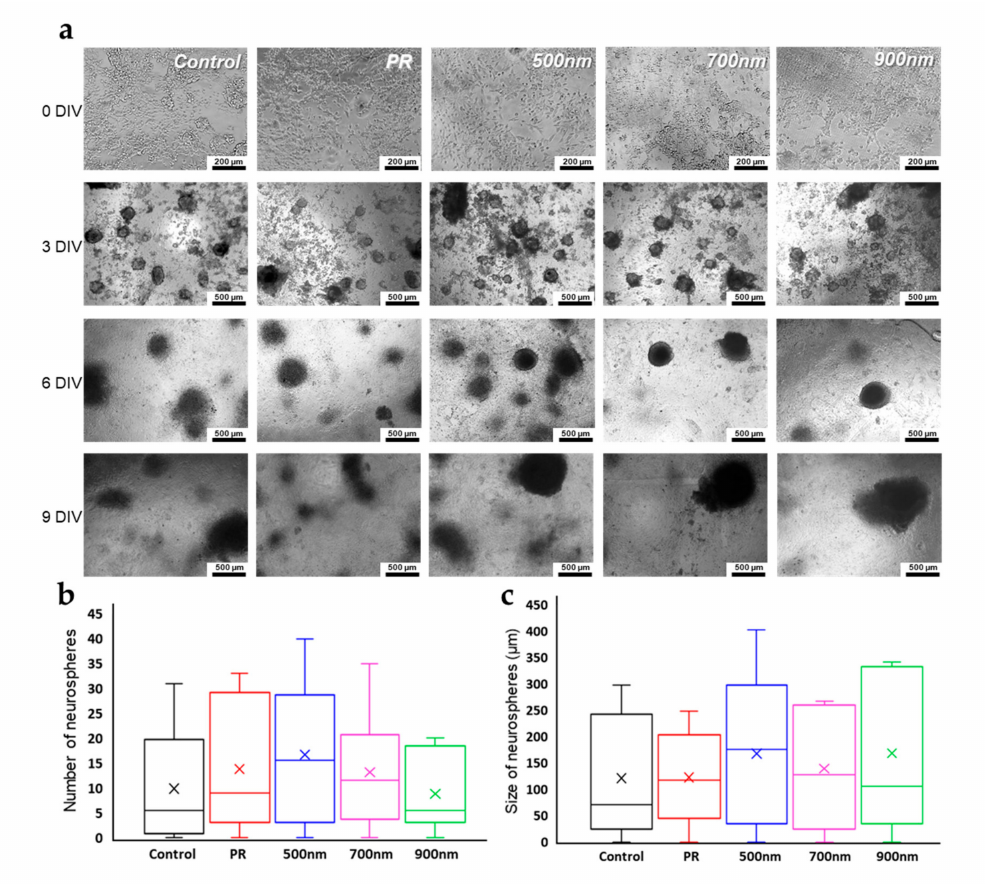
Figure 5. Neurosphere formation during cultivation of mNSCs. ( a ) The optical microscopic images of mNSCs cultured on HNPAs and non-patterned groups. ( b ) Number of the neurosphere of nNSCs cultured on HNPAs and non-patterned groups. ( c ) Size of the neurosphere of nNSCs cultured on HNPAs and non-patterned groups. Scale bar in top panel = 200 µ m; Scale bar in other panels = 500 µ m; n =